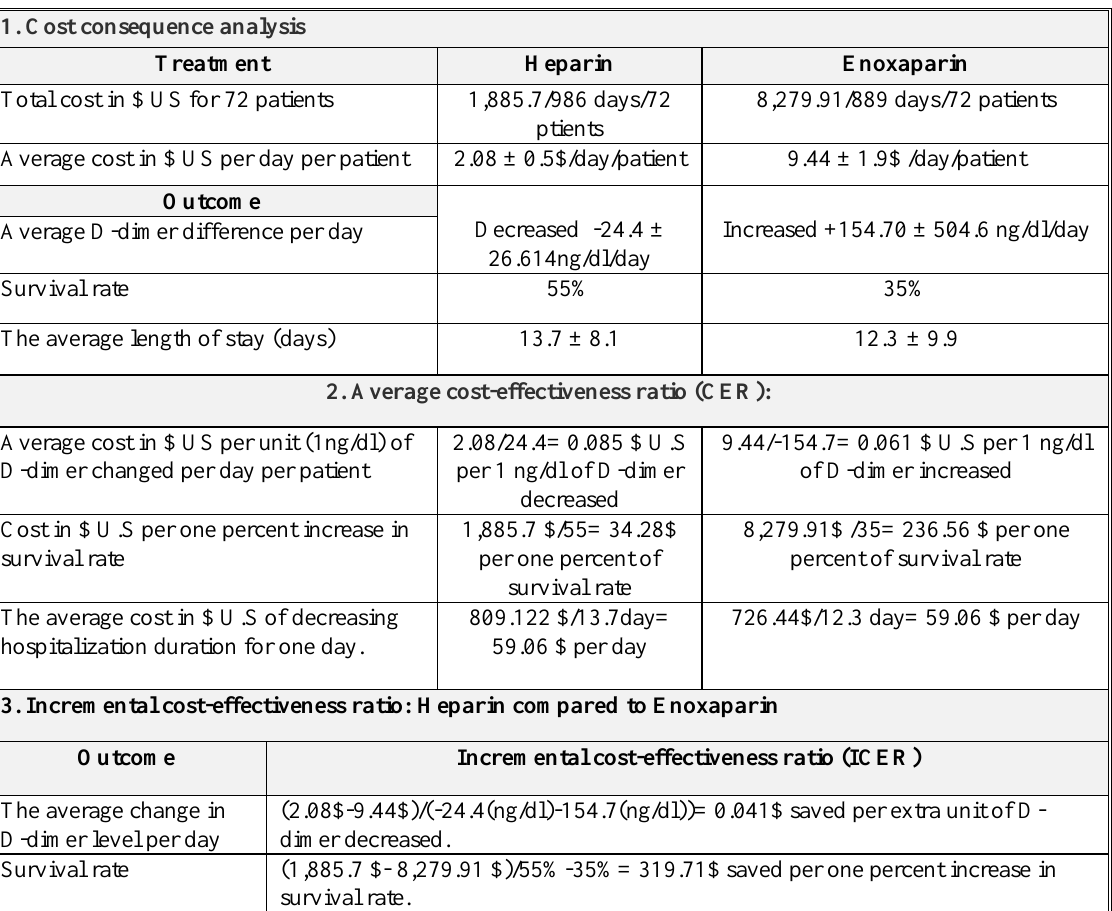
Table 9. presentation of cost vs effectiveness of anticoagulants (Heparin and Enoxaparin) for hospitalized, severe –critical COVID-19 infected